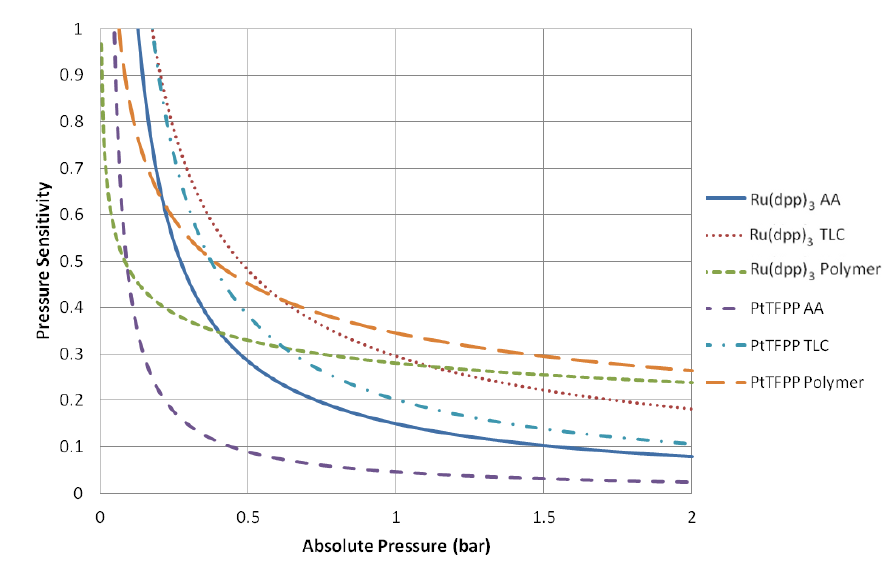
Figure 8. Pressure Sensitivity vs. Absolute